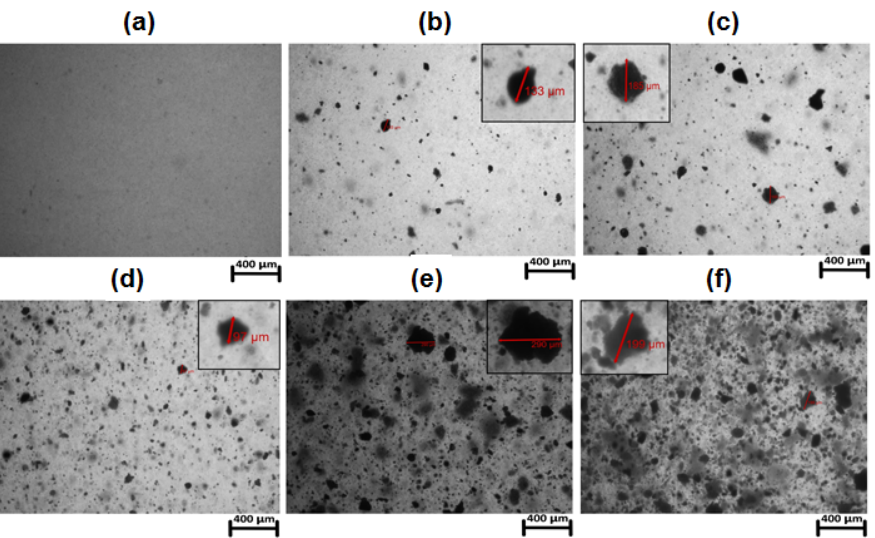
Figure 1. Scheme of the hybrid materials’ synthesis and proposed structure of obtained materials based on the europim(III) complex.